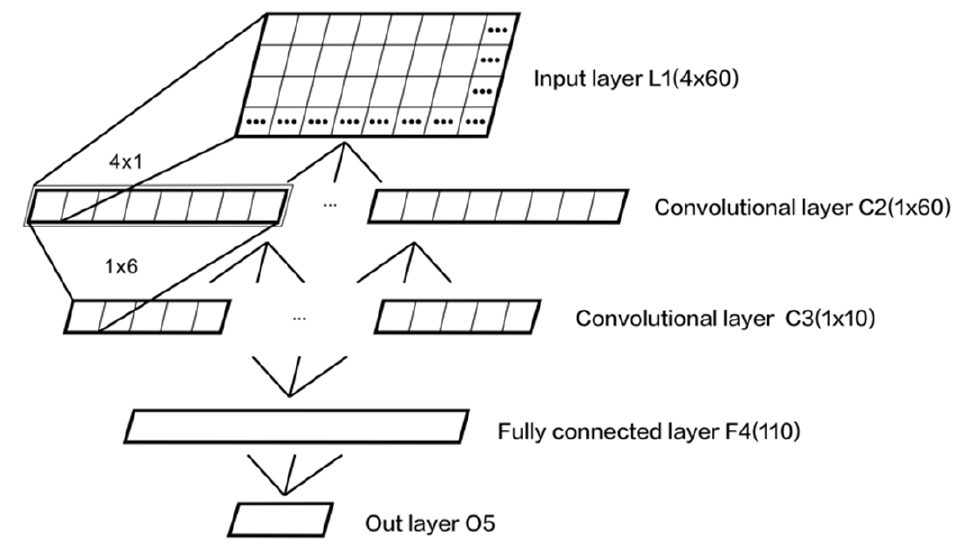
Figure 2. CNN Figure 2. CNN topology.